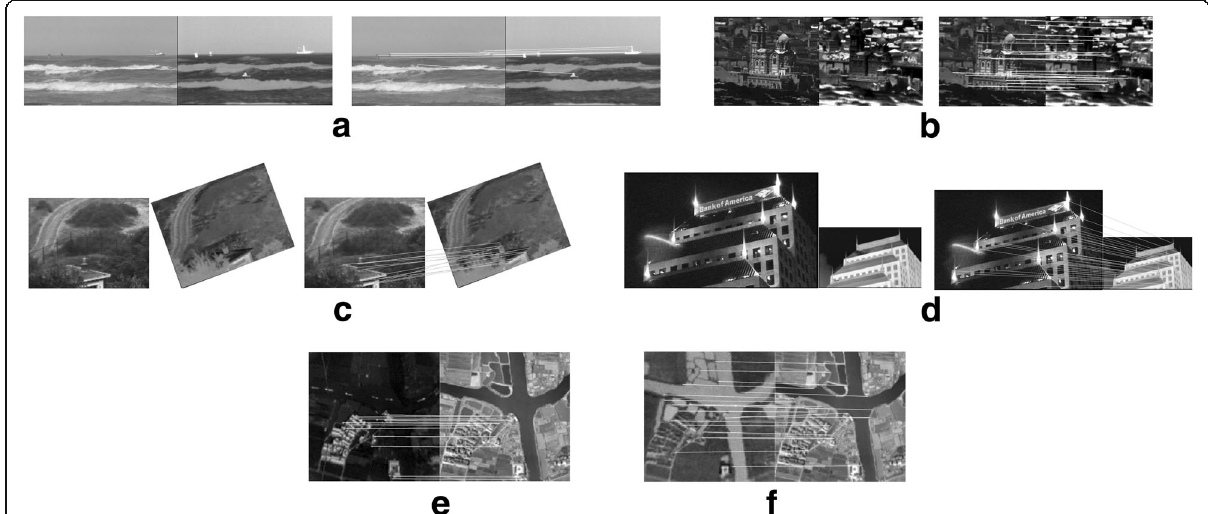
Fig. 4 The proposed method ’ s registration results. a The same scale and viewpoint. b Viewpoint transformation. c Rotation transformation. d Scale transformation. e Infrared image and visible lights in night. f Infrared image and visible lights in day